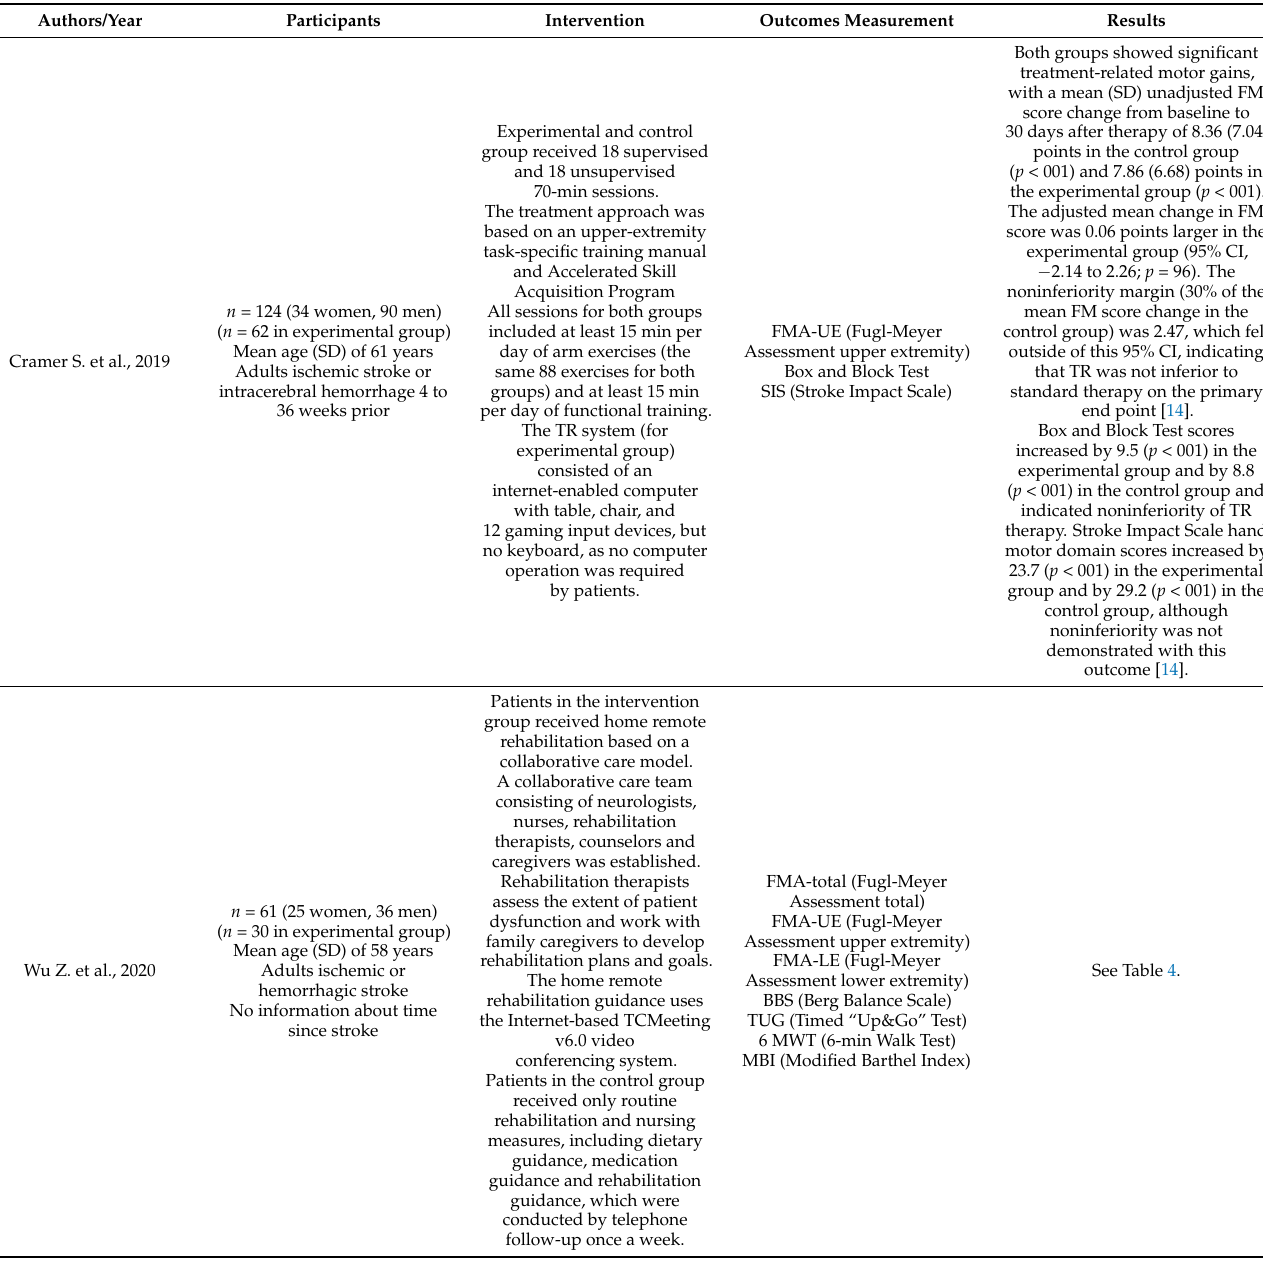
Table 5. Description of RCT included by PRISMA methodology in this